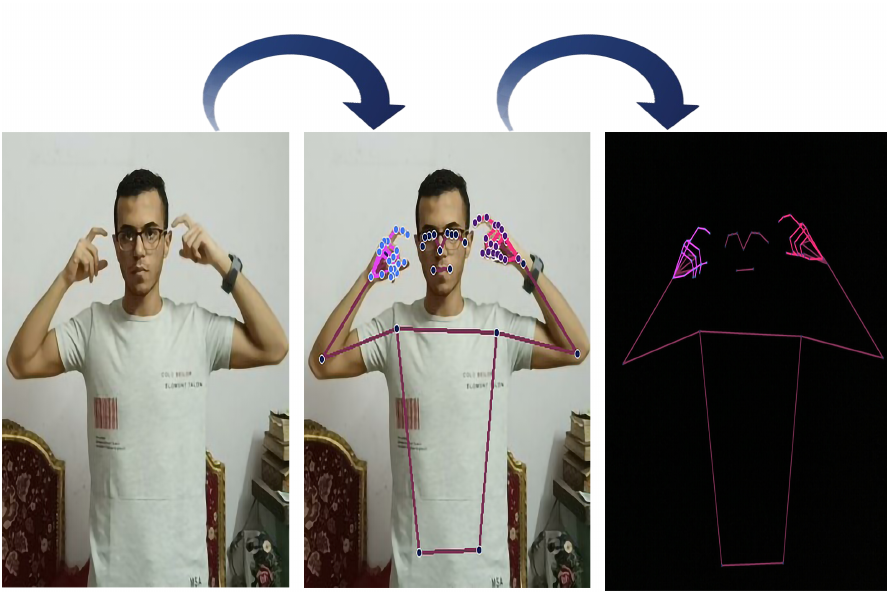
Figure 9. The stages of extracting the keypoints from the frame (Without include face keypoints). Table 2. Models accuracy without including face keypoints. GRU LSTM BILSTM Train accuracy 100% 99.9% 99.9% Test